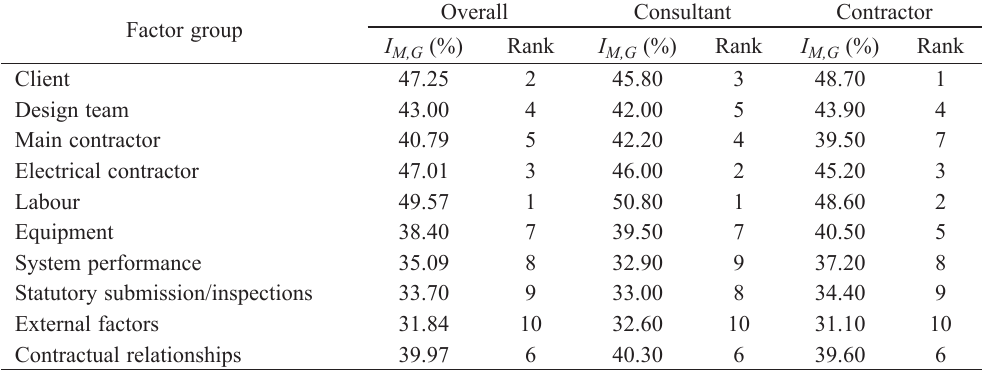
Table 3. Importance indices and ranks of factor groups Factor group